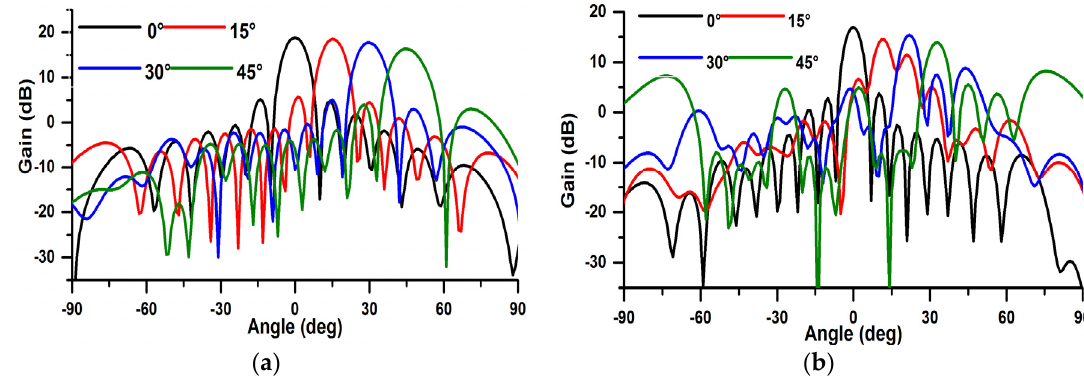
Figure 9. The cartesian gains of the 5G array antenna: ( a ) at 28.38 GHz and ( b ) at 38.49 GHz.